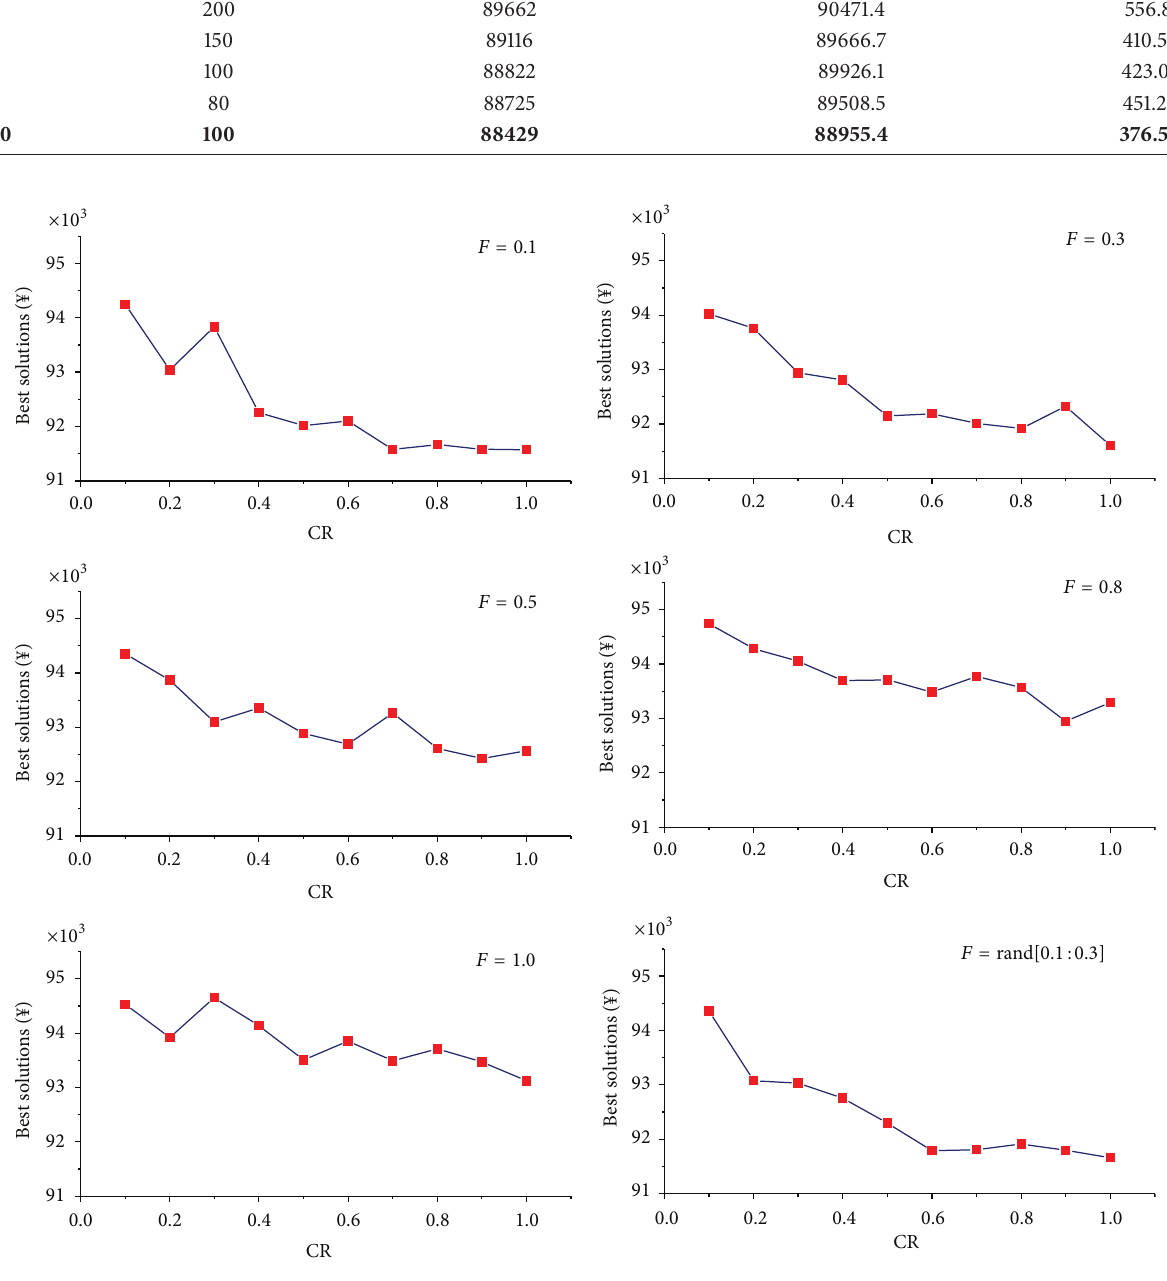
Figure 3: Analysis of CR in different 𝐹